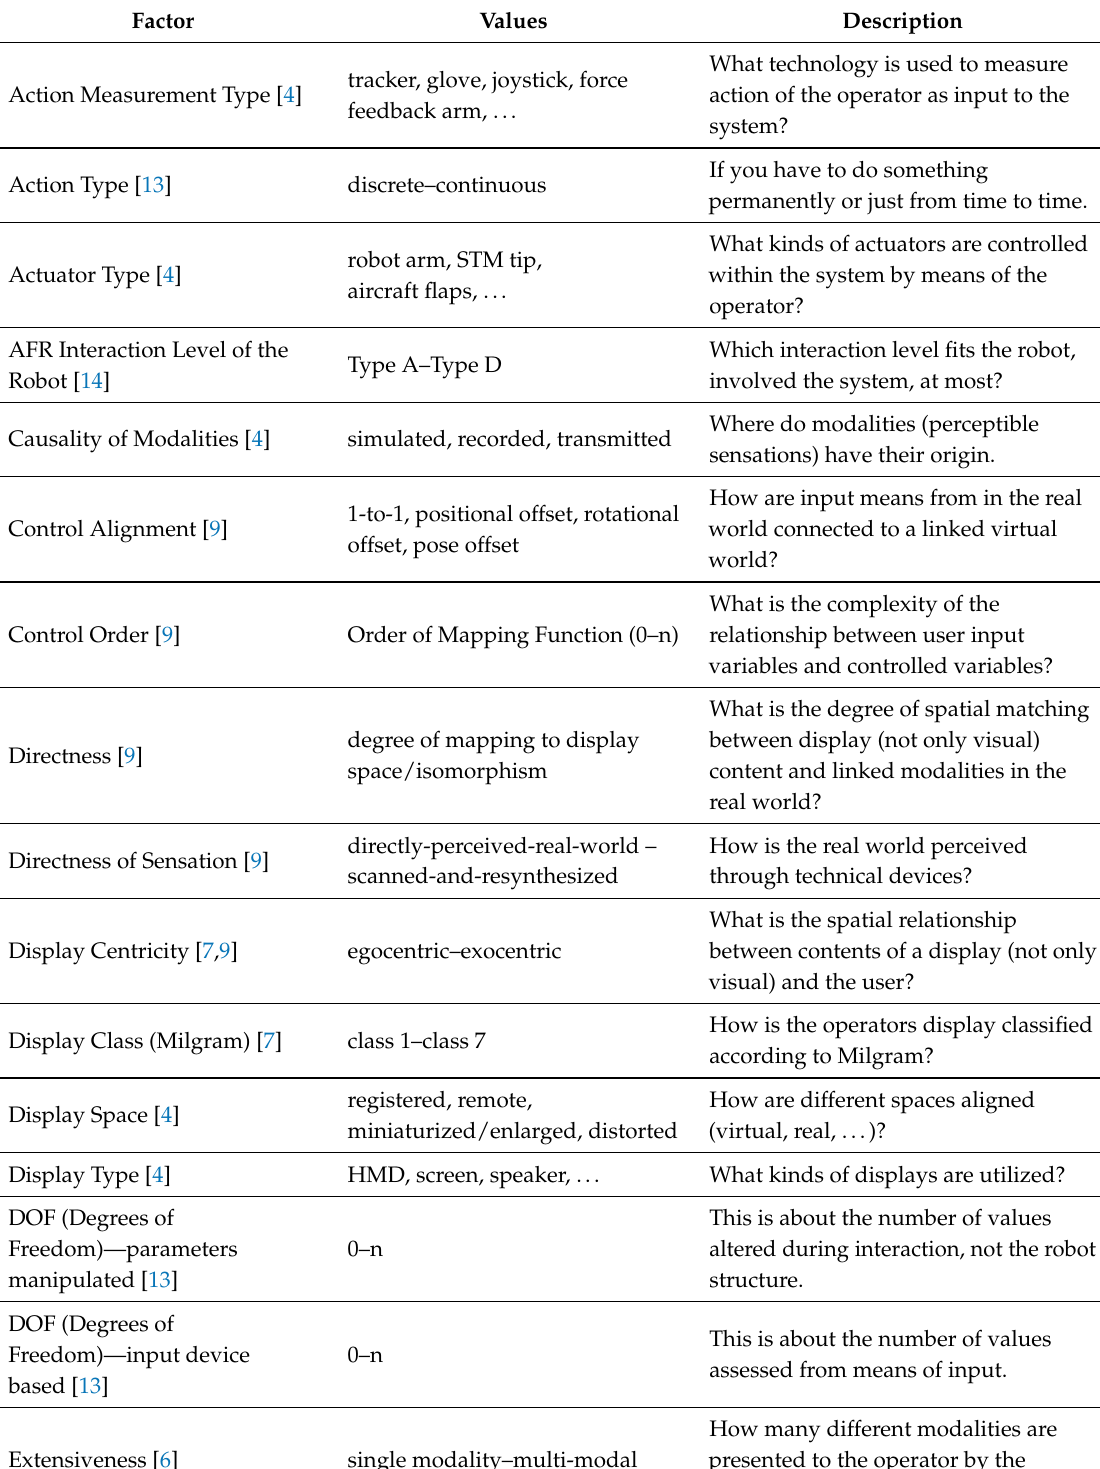
Table A1. This is the alphabetically-ordered list of the extracted relevant factors from the literature investigation including their possible values as lists or continua. Additionally, the descriptions placed on the backside of the cards from the card sorting experiment are